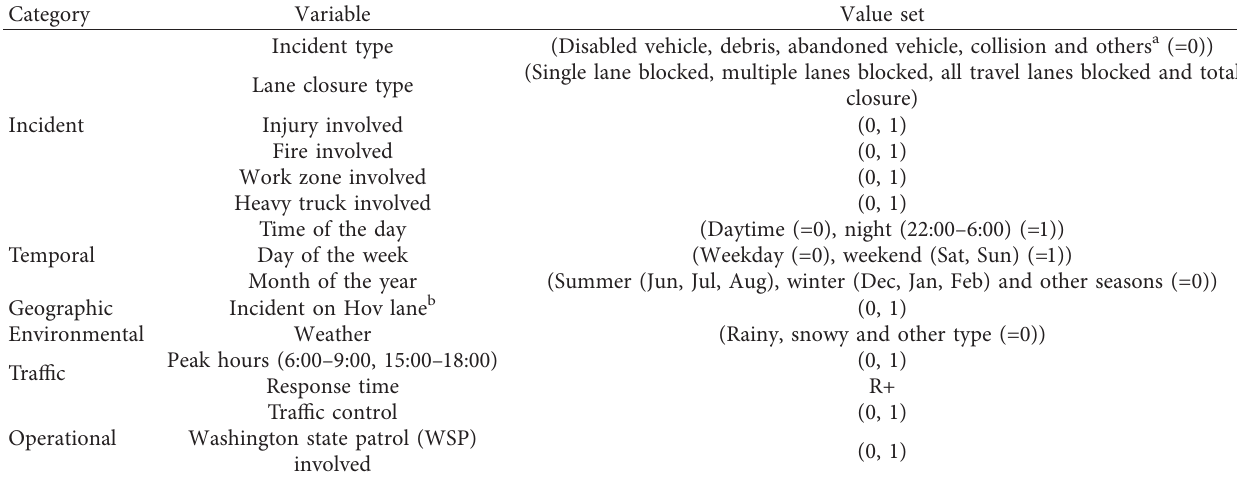
Table 1: The key information for valid incidents affected by candidate explanatory variables.